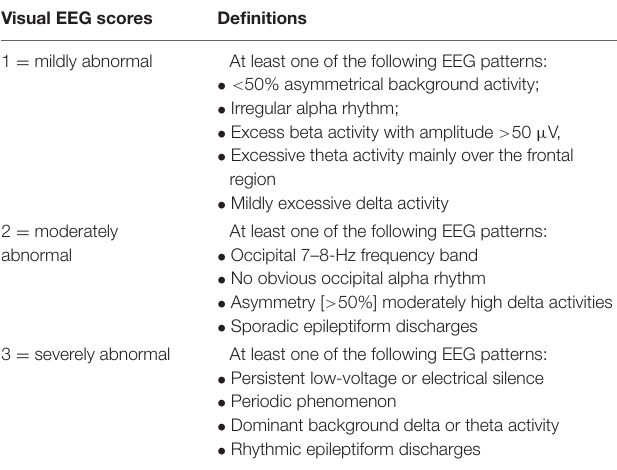
TABLE 1 | Definitions of visual EEG abnormality